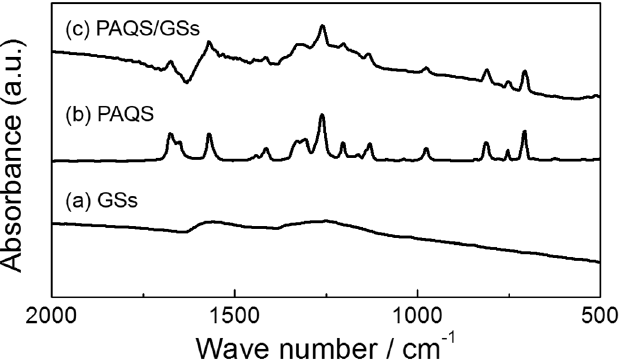
Figure 1. FT-IR spectra of ( a ) graphene sheets (GSs); ( b ) poly(anthraquinonyl sulfide) (PAQS); and ( c ) PAQS/GSs.